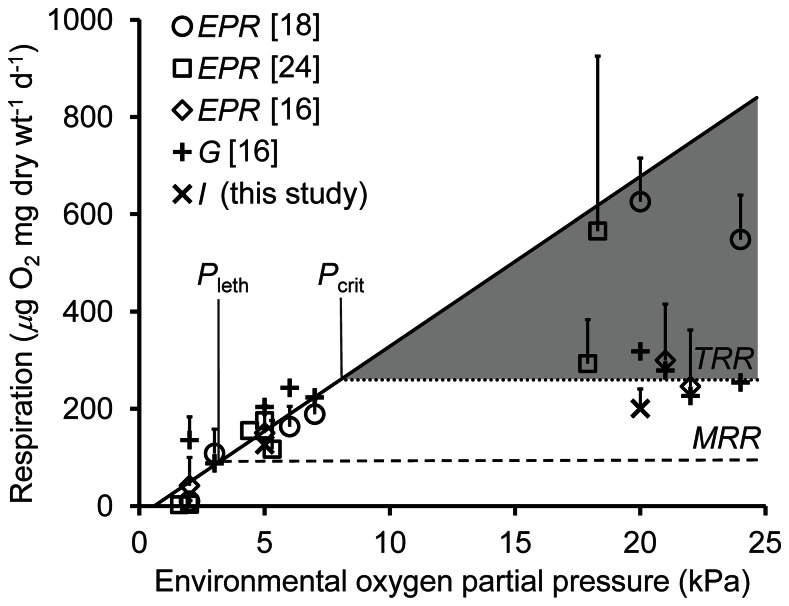
Relationship between Acartia tonsa respiration rate and environmental oxygen partial pressure.Using the same concepts illustrated in Fig. 1, analogous respiration rates (ARR) are plotted against associated environmental oxygen partial pressures. Theoretical maximum respiration rate (solid black line) is the linear regression through all data <8 kPa oxygen partial pressure. Target respiration rate (TRR, dotted line) is the average of normal respiration rates for A. tonsa (from 10 studies reviewed in [29]). Minimum survivable respiration rate (MRR, dashed line) is the average of respiration rates of persistently starved A. tonsa (reported in [20], [30]). A. tonsa critical oxygen partial pressure (P
crit, based on TRR) and lethal oxygen partial pressure (P
leth, based on MRR) are also indicated. Gray shading indicates the region of oxygen independent respiration. Each type of symbol indicates a specific data source (citations on graph) and whether the measurement was of egg production rate (EPR), somatic growth rate (G), or ingestion rate (I). Error bars are+SD. ARR values are means at each distinct oxygen partial pressure and within each study, and the linear regression is based on 17 mean ARR values from a total of 153 individual measurements (see text for details). Regression statistics: y = 34.9×–20.5; R2 = 0.735; slope p-value <0.0005; n = 17.